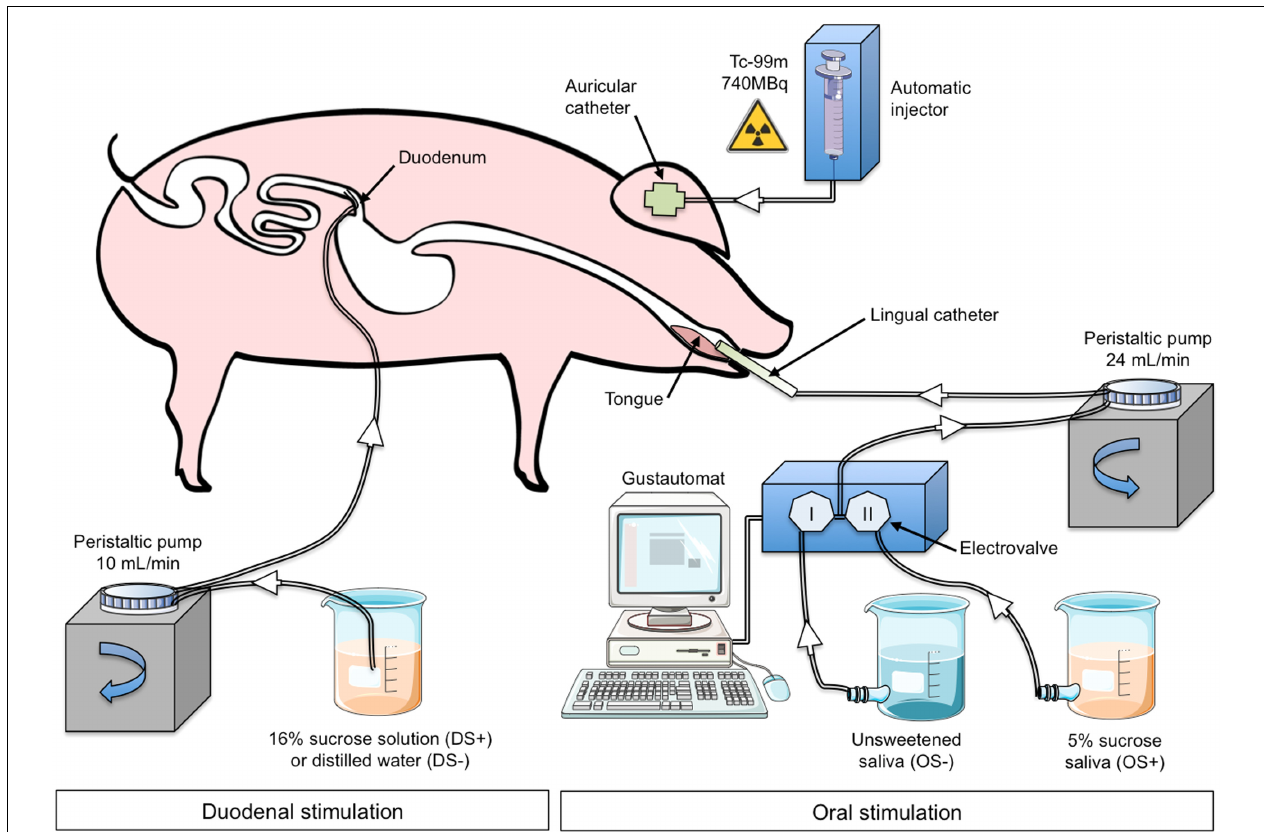
FIGURE 1 | Experimental device and paradigm designed to perform oral (OS) and duodenal (DS) stimulations for brain imaging in anaesthetized pigs. The illustrations used to make this figure were obtained from the “Servier Medical Art” website, http://www.servier.fr/servier-medical-art. OS–: